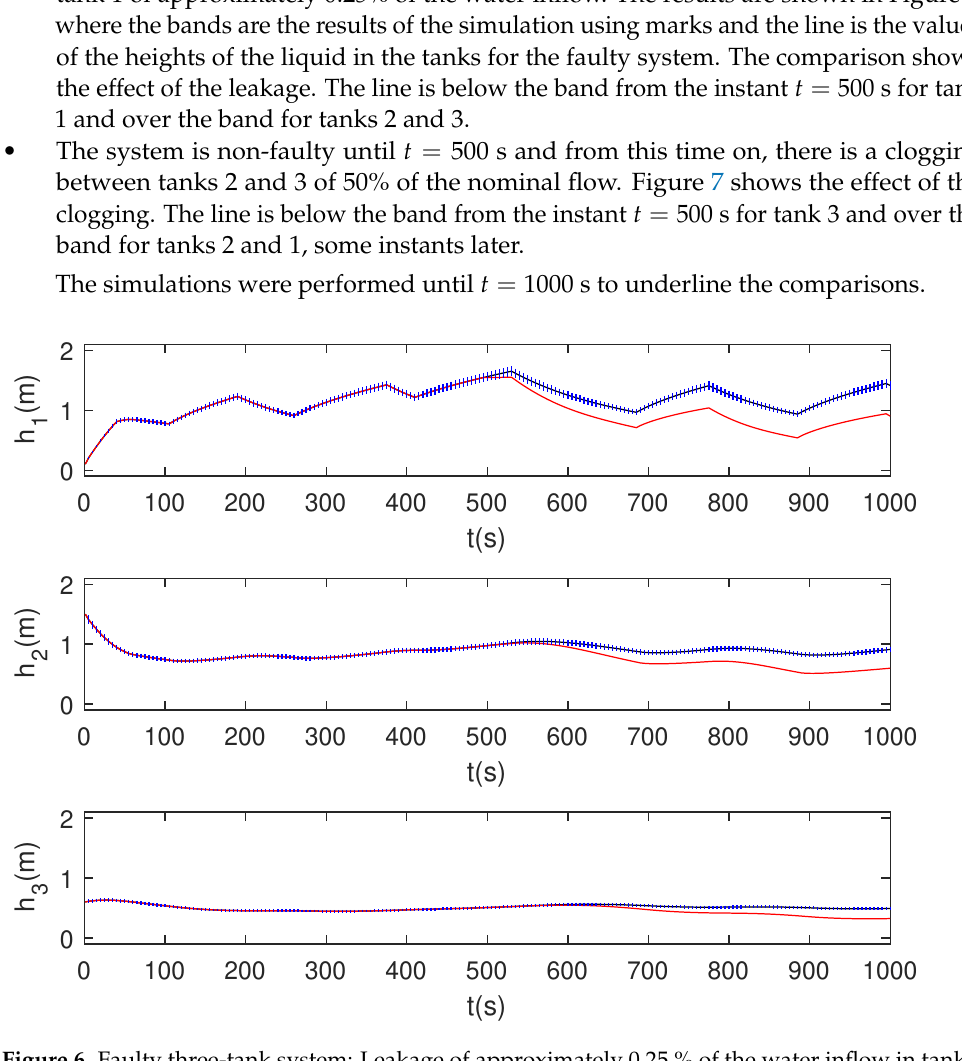
Figure 6. Faulty three-tank system: Leakage of approximately 0.25 % of the water inflow in tank 1 from t = 500 s. Blue bands represent the computation using marks while red lines correspond to the measured values of the three state variables